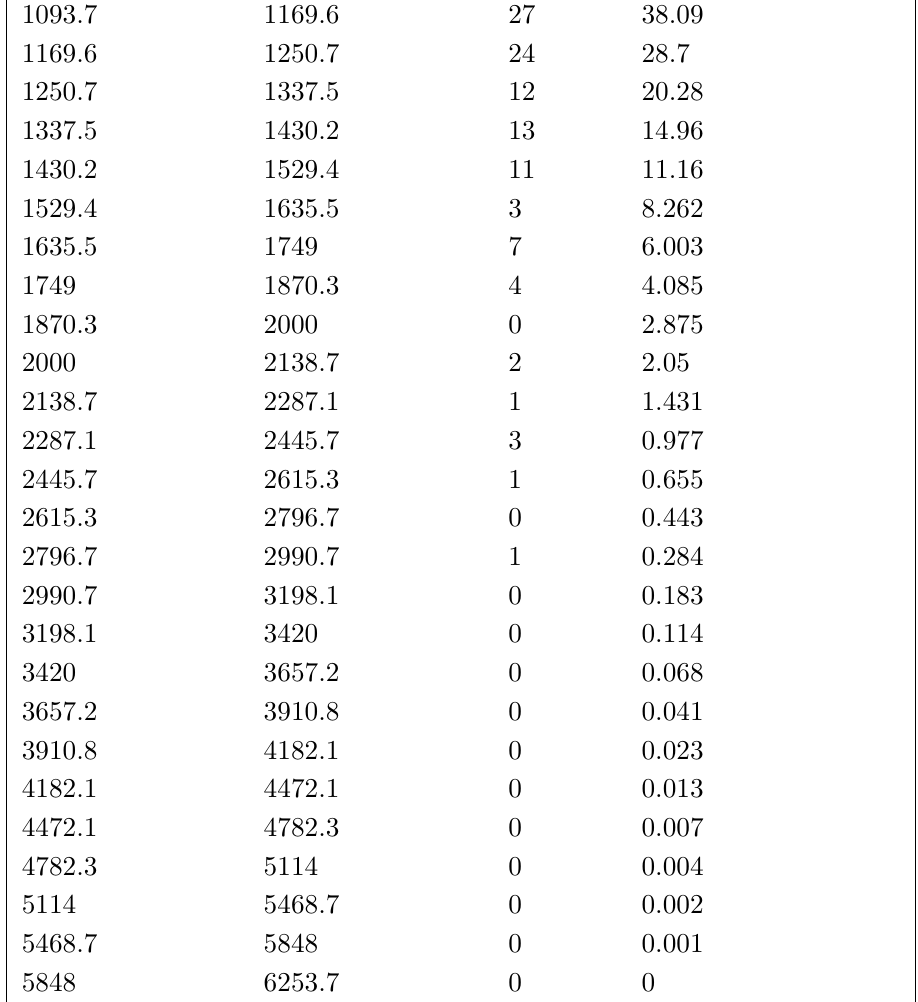
Table 8. Expected and observed event yields in the dielectron channel, directly corresponding to the non-linear binning presented in (cid:12)gure 1a. The expected yield is given up to at most 4 digit